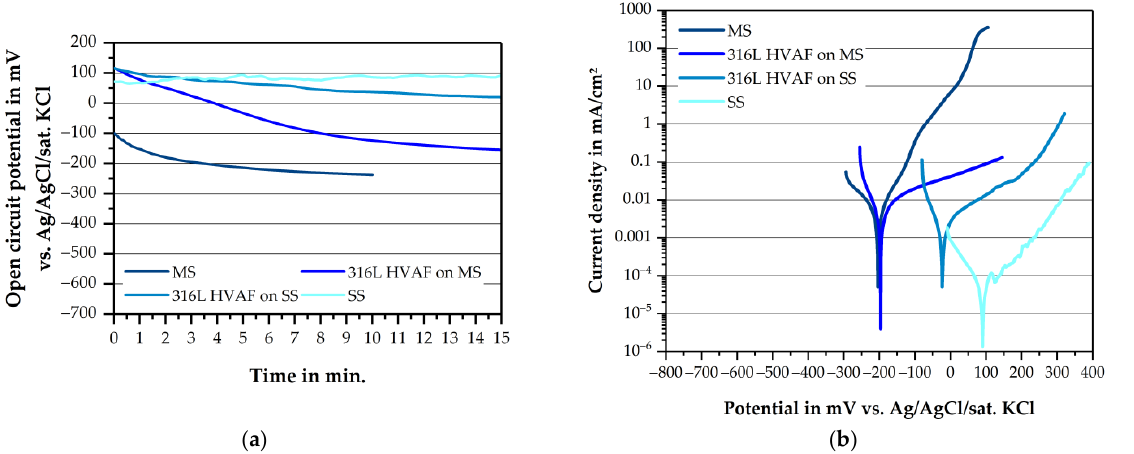
Figure 5. Representative curves of the electrochemical measurements in the 3.5% NaCl solution for the AISI 316L HVAF coatings on mild steel (MS) and stainless steel (SS) and reference bulk materials, mild steel (MS) and stainless steel (SS): ( a ) OCP and ( b ) polarization